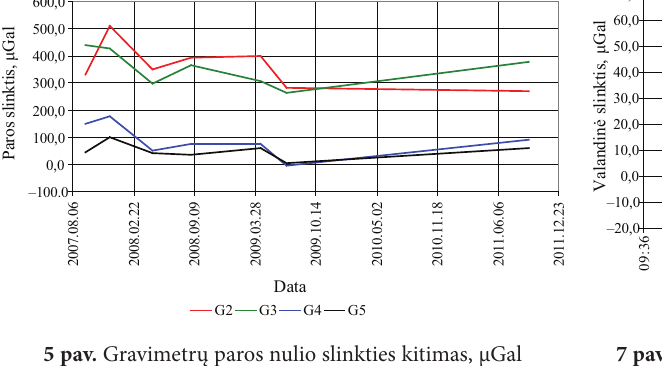
Fig. 5. The changes of the gravimeters daily Fig. 7. The zero drift in between the vertical zero drift μgal gradient observations analizuojant grafikus matyti, kad valandinės nulio slinkties svyravimas matavimų metu daugeliu atvejų ne- viršija 30 μgal. analizuojant valandinę slinktį gradiento matavimo metu, nustatyta, kad g2, g3, g4 ir g5 gravi- metrų slinkčių medianos yra atitinkamai 23,0, 25,2, 9,7, 0,9. tai patvirtina, kad g2 ir g3 gravimetrų valandinės slinktys yra didesnės nei g4 ir g5 gravimetrų. taigi, ma- tuojant pastate, gravimetrų nulio slinkties svyravimas padidėja iki 3 kartų.